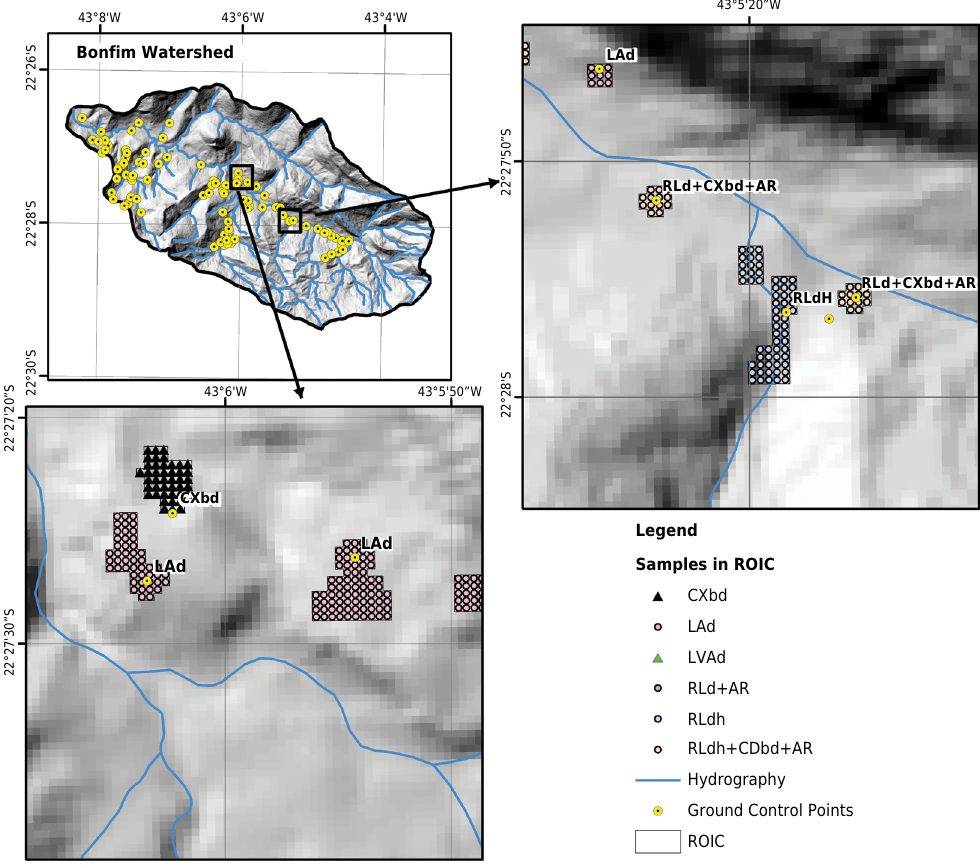
Figure 2. Spatial distribution of point samples in ROICs around the GCPs over the DEM hillshade, in which CXbd: Inceptisols; LAd and LVAd: Oxisols; RLd and RLdh: Lithicsols.